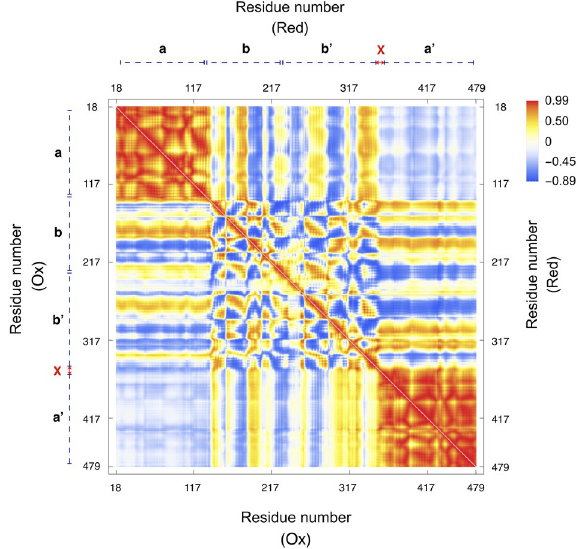
Figure 2. Cross-correlation matrix of atomic displacements around their average values for ox-hPDI (lower triangles) and red-hPDI (upper triangles). Values are ranged between 1 (red) and -1 (blue) for correlated and anti-correlated motions, respectively.